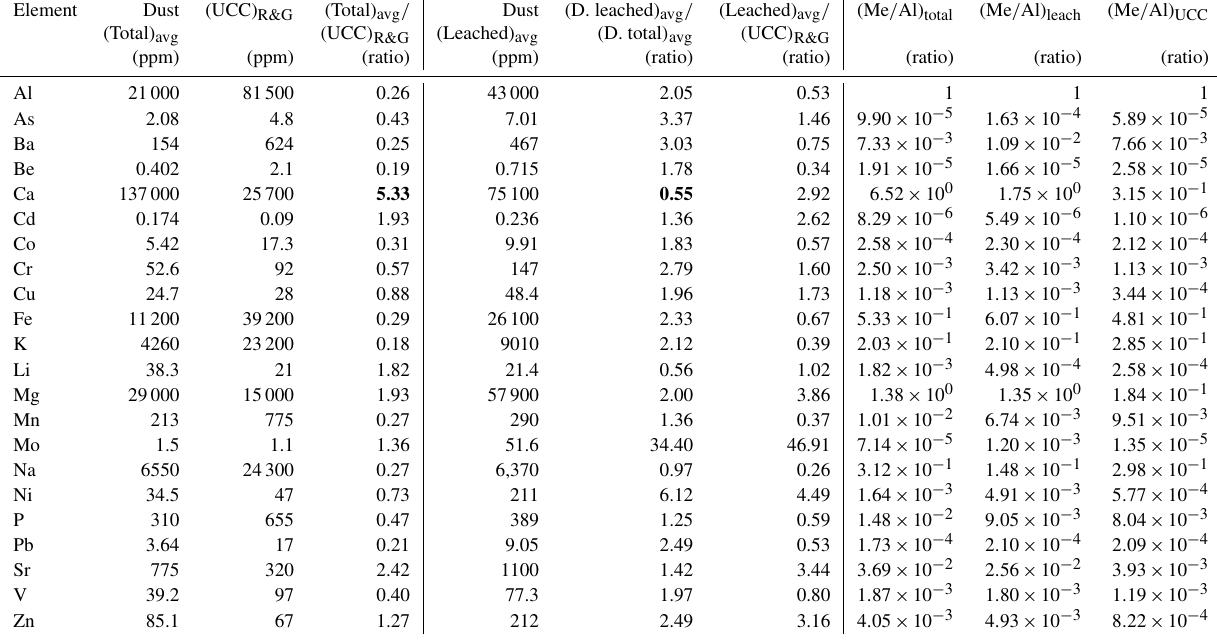
Table 1. Average composition of five representative samples of total (strong acid-digested, unleached) Qatari dust, comparison with the average Upper Continental Crust (UCC; Rudnick and Gao, 2003), and composition of leached (total minus labile) Qatari dust. The total and leached compositions are compared with each other and with the UCC as ratios. The unleached and leached compositions are also given as Me / Al ratios. Bold values: calcium (Ca) is the major element of the Qatari dust, which has the highest value in column 4, while having the lowest value in column